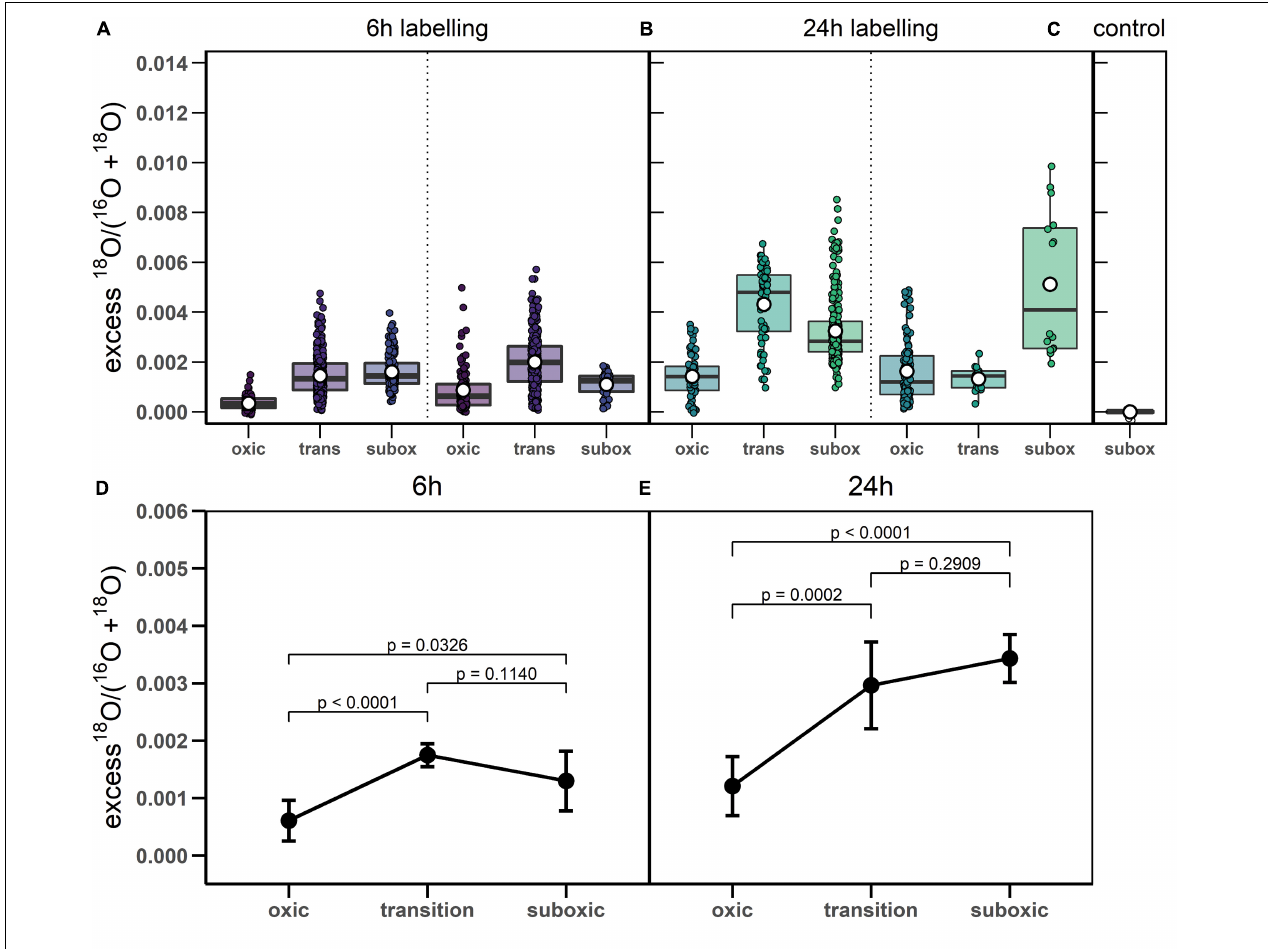
FIGURE 4 | 18 O labeling of polyphosphate granules in cable bacteria. (A-C) Boxplots show excess 18 O atom fractions in individual poly-P granules, separately for the 6 h and 24 h labeling periods and for the control cells. Dotted lines separate data obtained from replicate sediment cores. Shown are the corresponding mean (white open dot), median (black line) and upper and lower quantiles of the excess 18 O atom fraction. Note that grouping of poly-P granules within cells and within filaments is not indicated in the graphs. (D,E) Results of the linear mixed model used for fitting the variance in the excess 18 O atom fractions in poly-P granules. Results are shown separately for the 6 h and 24 h labeling period. Black circles and error-bars depict the best estimates and the lower and upper confidence limits (95%) of the mean value for each zone and labeling period (exact values provided in Supplementary Table 1 ). The p-values indicate the significance of differences between zones (summarized in Supplementary Table 2 ). Raw data is provided as Supplementary Dataset 1 , the step-by-step build-up and outcomes of the linear mixed model are available in Supplementary Methods